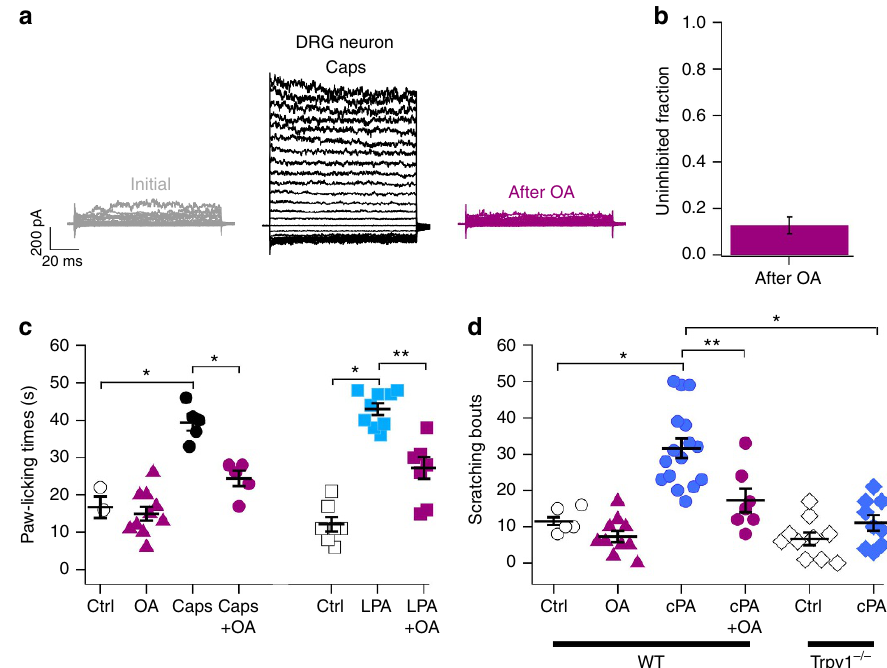
Figure 6 | Oleic acid attenuates painful and pruritic behaviours. ( a ) Representative TRPV1 currents (as obtained as in Fig. 2) from an inside-out patch from DRG neuron before (grey traces) and after exposure to 4 m M capsaicin (black traces). After wash, 5 m M OA was added for 5min and the patch was re-exposed to capsaicin (magenta traces). ( b ) The fraction of uninhibited currents was 13 ± 3.6%, as obtained by normalizing the data obtained in the presence of capsaicin after OA to the data obtained with capsaicin before OA ( n ¼ 9). ( c ) Average paw-licking times were: 16.7 ± 2.9s for capsaicin and 12.1 ± 1.9s for LPA vehicle injections (Ctrl; n ¼ 3–7); 15.0 ± 1.8s for OA ( n ¼ 10); 39.4 ± 2.1 for capsaicin ( n ¼ 5) and 43 ± 1.6s for LPA ( n ¼ 9); 24.4 ± 2s for Caps þ OA ( n ¼ 5) and 27.2 ± 2.9s for LPA þ OA ( n ¼ 8). * P o 0.001 and ** P o 0.0001 between groups as compared by the brackets. Also see Supplementary Table 2. ( d ) The average number of scratching bouts were: 11.6 ± 1.1 for vehicle-injected (Ctrl; n ¼ 10); 7.3 ± 1.6 for OA ( n ¼ 10); 31.6 ± 2.7 for cPA ( n ¼ 16); 17.3 ± 3.2 for cPA þ OA ( n ¼ 7) for WTanimals and 6.7 ± 1.7 for control ( n ¼ 10) and 11.1 ± 2.1 for cPA-injected ( n ¼ 9) Trpv1 (cid:2) / (cid:2) mice. For WT mice: * P o 0.0001 and ** P o 0.01 between groups as compared by the brackets. Also see Supplementary Table